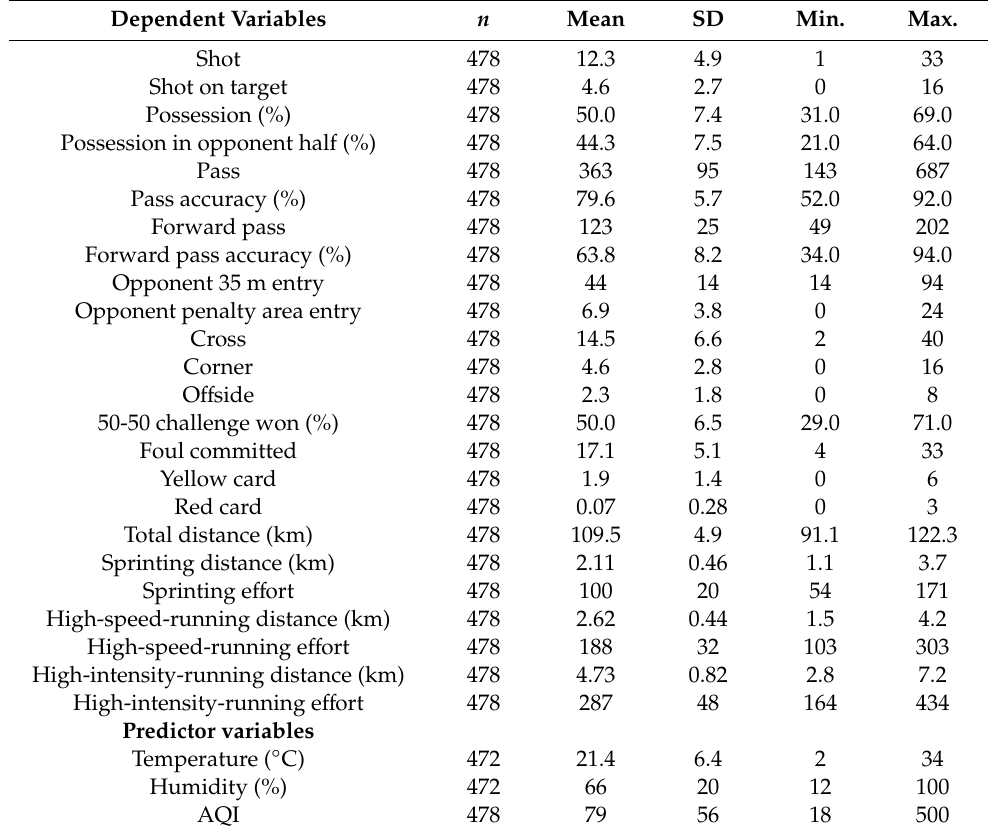
Table 2. Descriptive statistics of all The analysed